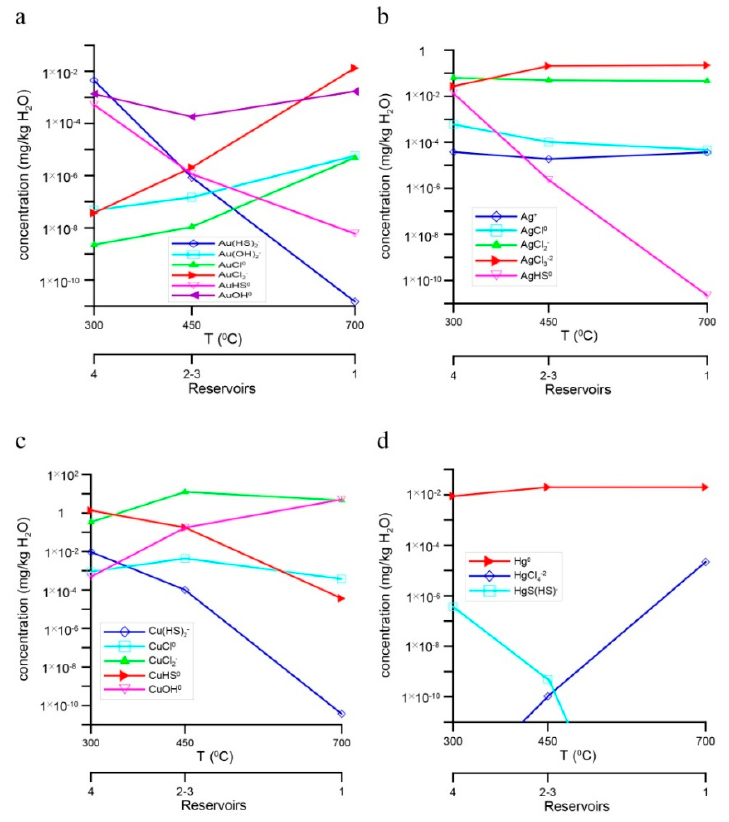
Figure 9. Content of different forms of metal complexes in ore-bearing solution containing average contents of ore components in ultramafic rocks: ( a ) Au, ( b ) Ag, ( c ) Cu, and ( d ) Hg.